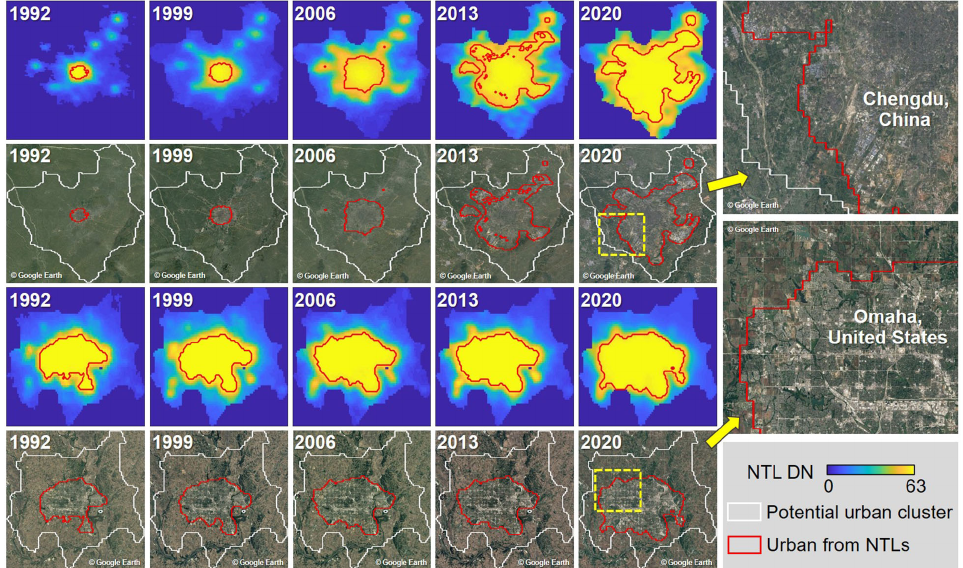
Figure 9. Comparisons of urban extent from NTL observations with Google Earth imagery for two selected urban clusters in 1992, 1999, 2006, 2013, and